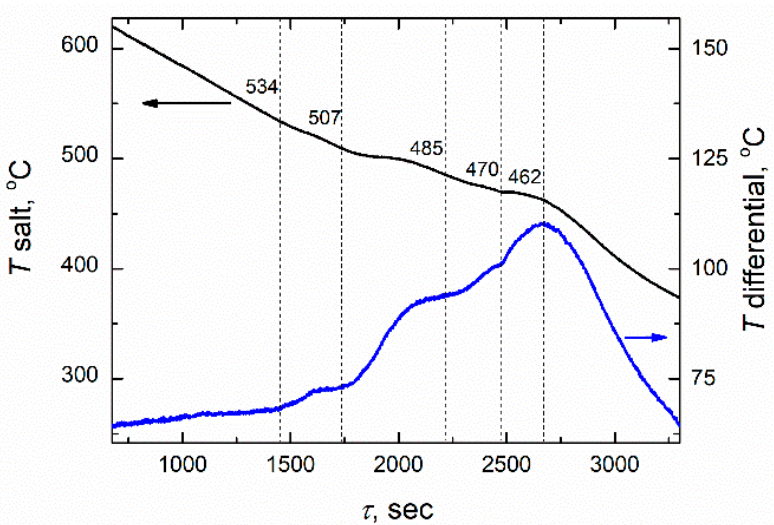
Figure 6. Cooling and differential curves obtained in the system FLiNaK + 15 mol.% NdF 3 .